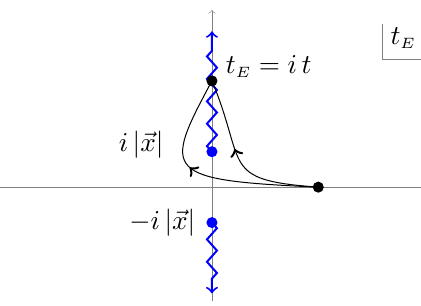
Figure 1 . The two different Wick rotations from Euclidean to Lorentzian time, corresponding to passing either to the right or the left of the branch cut, define the two possible Wightman 2-point functions. The contour on the right corresponds to (0) ( x ) hO O i